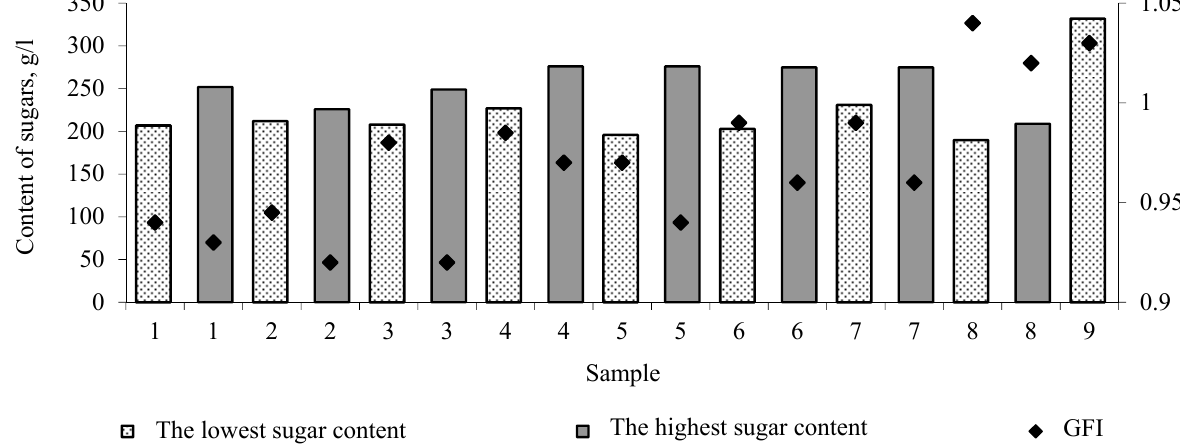
Fig. 2. Glucose-fructose index (GFI) in the must of various grape varieties depending on sugar accumulation (in the studied sample). Grape variety: (1) Aligote, (2) Sauvignon Green, (3) Rkatsiteli, (4) Kokour White, (5) Muscat White, (6) Cabernet Sauvignon, (7) Bastardo Magarachski, (8) Golubok, (9)